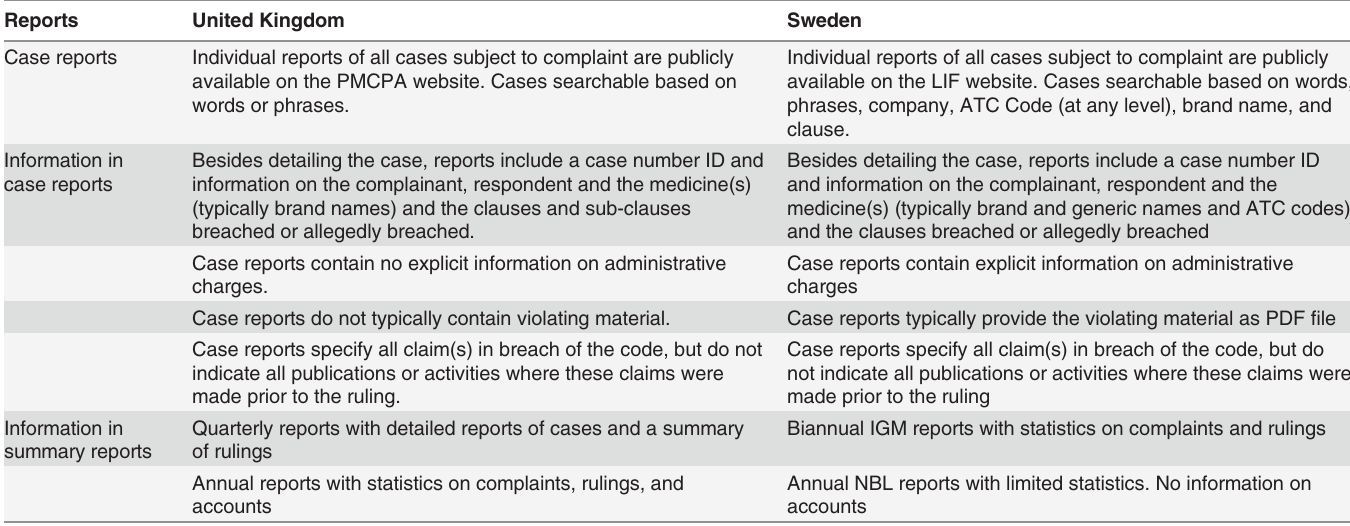
Table 1. Information from self-regulatory bodies in the UK and